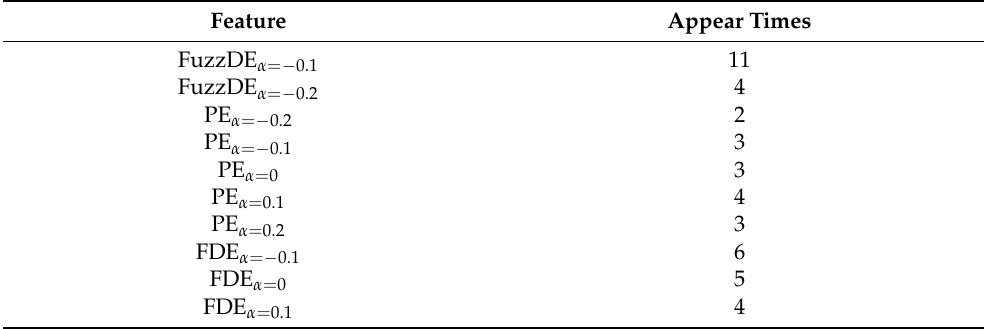
Table 5. Number of occurrences of each feature in the combination of the mixed triple features with 100% recognition